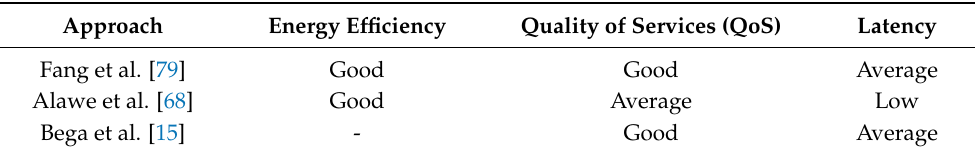
Table 10. The state-of-the-art ML-based approaches in 5G technology. Approach Energy Efficiency Quality of Services (QoS) Latency Good